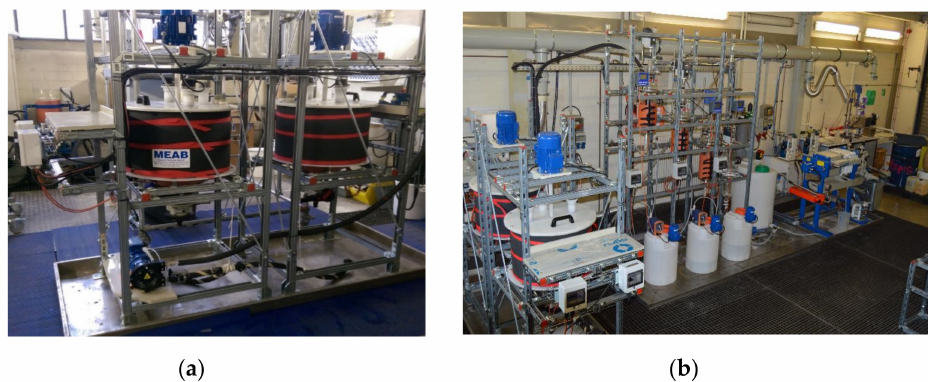
Figure 6. ( a ) Two reactors for leaching (2 × 100 L), ( b ) System for leaching, neutralization, and filtration. Main components: neutralization unit (3 reactors × 10 L and 1 × 8.5 L), stirred collecting tank (250 L) and separation unit (chamber filter